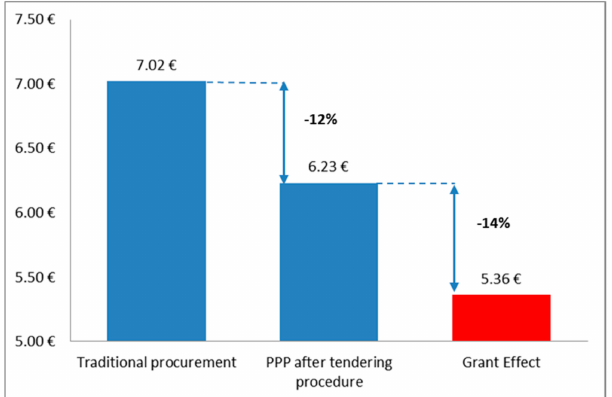
Figure 6. Value-for-Money analysis with grant e ff ect. Source: Authors’